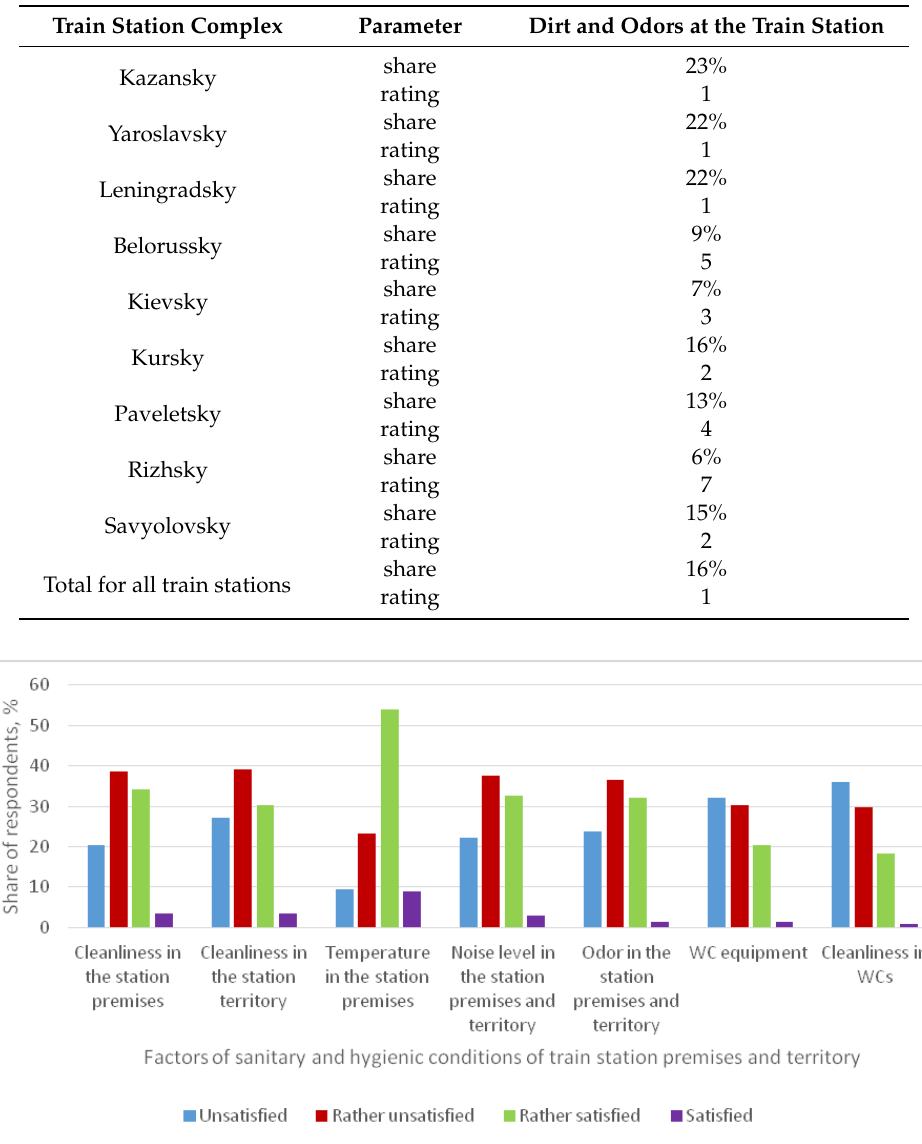
Figure 3. Degree of respondents’ satisfaction with the sanitary and hygienic conditions of the premises and the territory of the train stations.